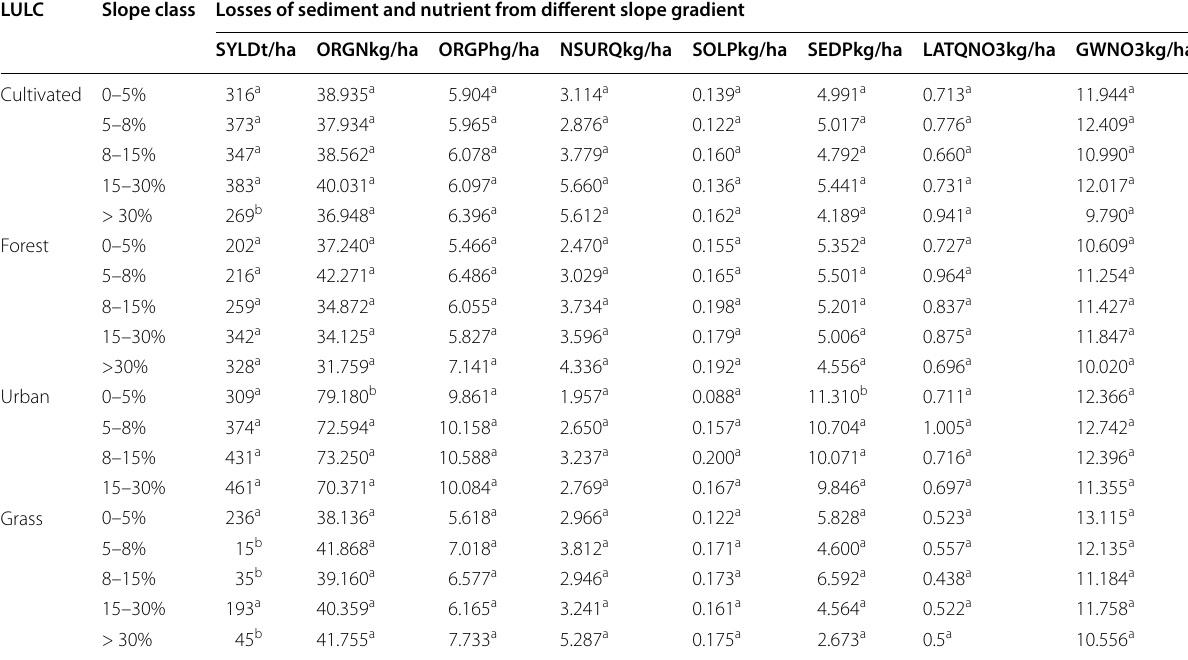
Table 4 Simulated mean values of sediment and nutrient loss from the combination of LILC and slope gradient